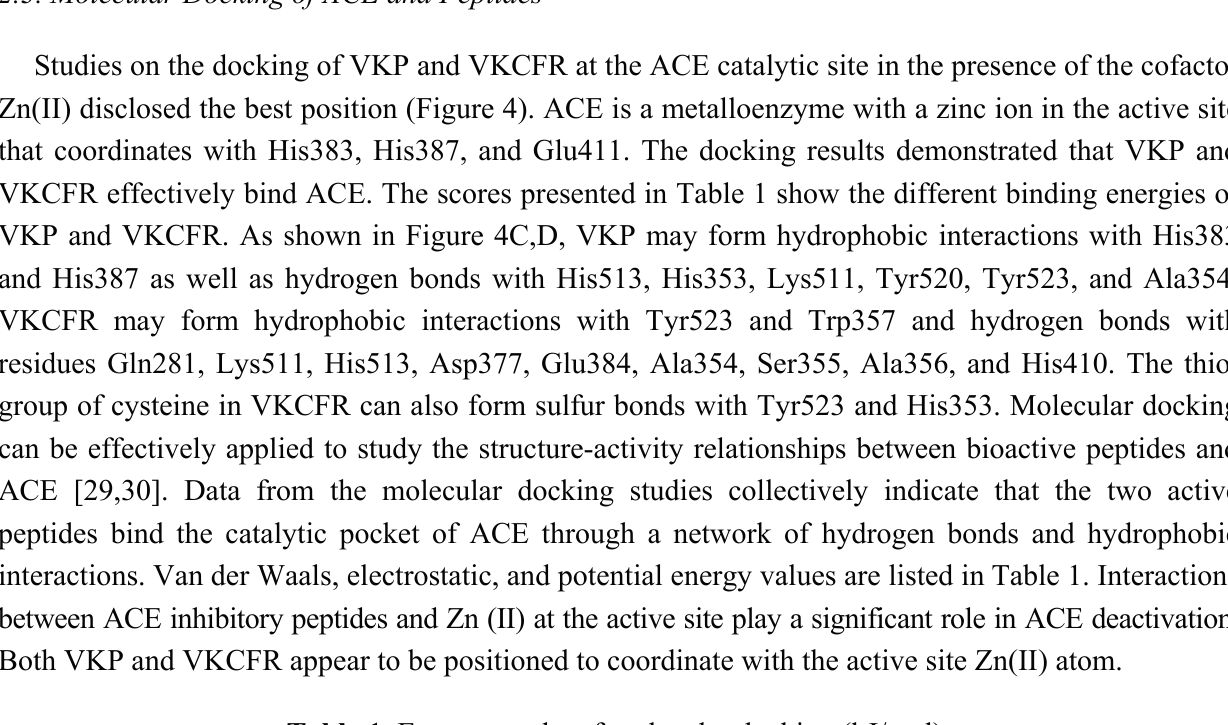
Table 1. Energy results of molecular docking